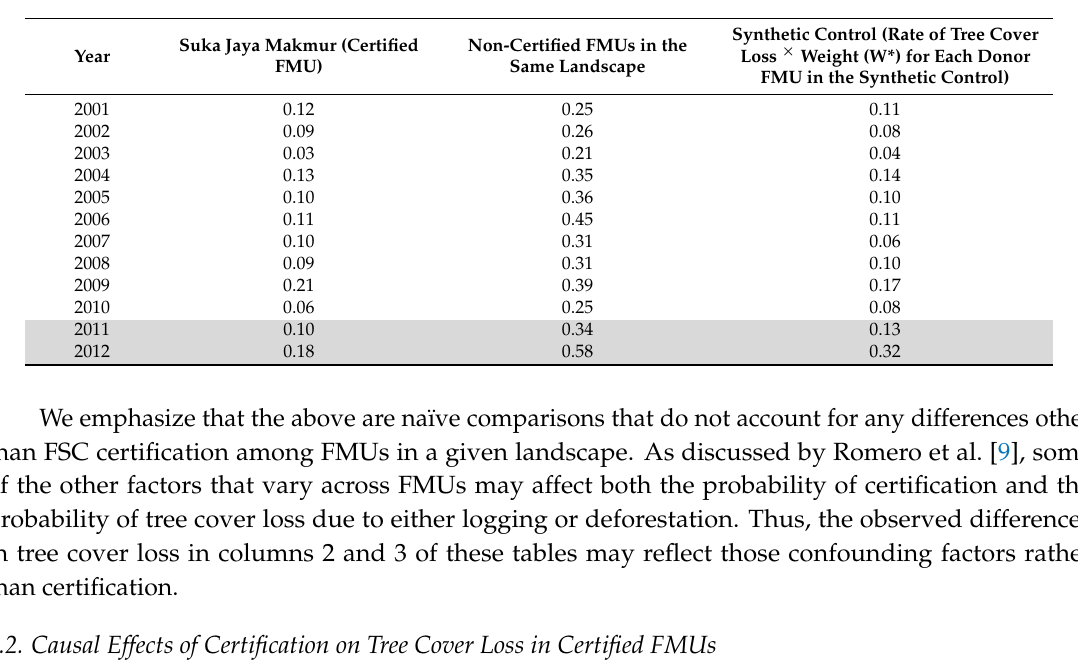
Table 3. Percent of tree cover lost annually in FMUs in Kalimantan. Shaded rows correspond to years after FSC certification of Suka Jaya